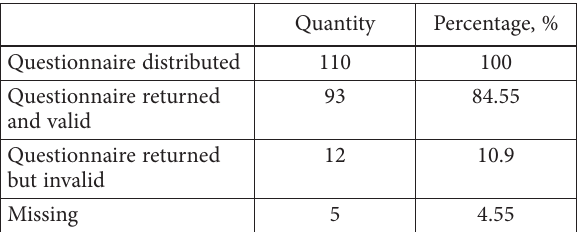
Table 2. Cronbach’s alpha value for questionnaire Type of questionnaire